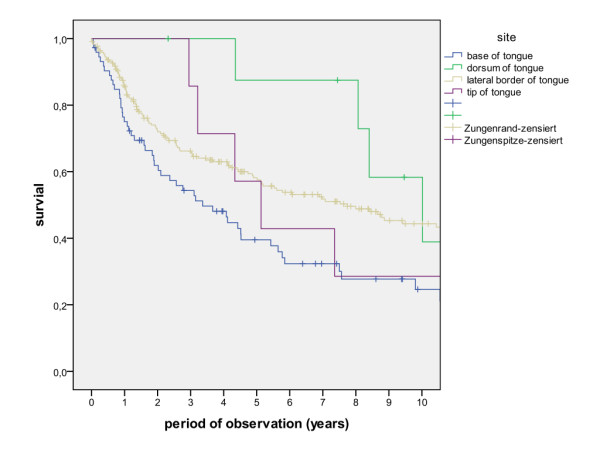
Suvival of patients with different tumour sites (log rank p = 0.005).